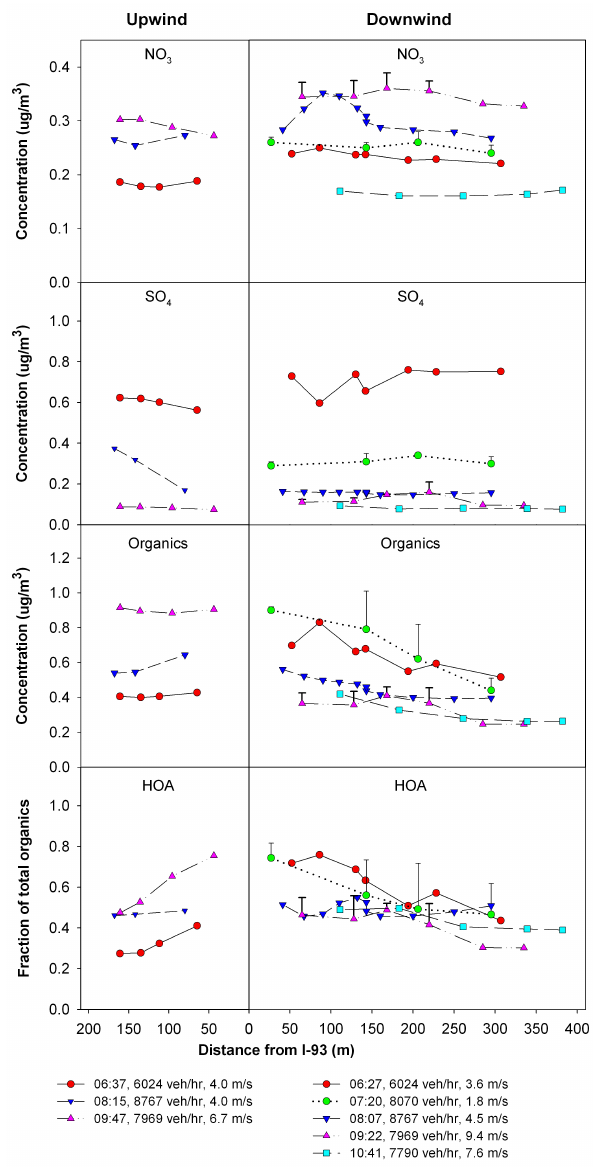
Fig. 7. Spatial and temporal variation of NO − aerosol and fraction hydrocarbon-like organic aerosol (HOA) along transects perpendicular to I-93. Legend shows vehicles per hour on I-93 (both directions) and average hourly wind speed. Error bars (one SD) are shown at locations where the AML stopped briefly and multiple measurements were made. The spike in the 07:20 and 09:47 organic aerosol profiles likely represent the plumes from ve- hicles passing nearby the